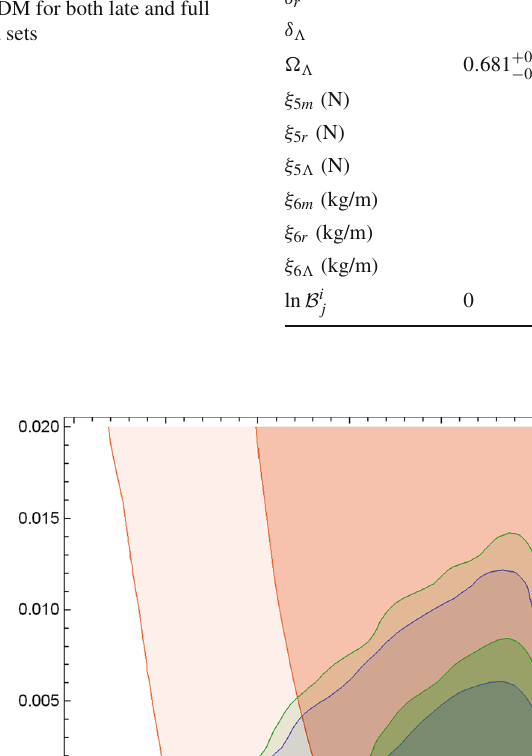
Table 5 In the table, we report the constraints on our model parameters for ansatz 4 and (cid:2) CDM, both tested against the same combination of data sets. From the reported Bayes factors, our model with ansatz 4 is disfavoured with respect to